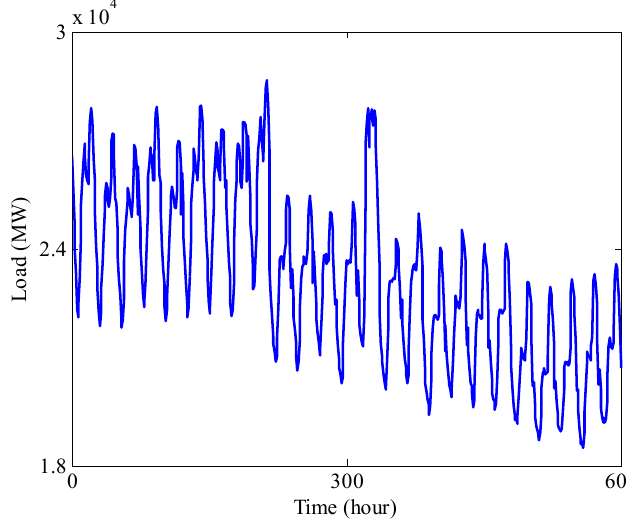
Figure 7. The training hourly actual load data in Case 3.